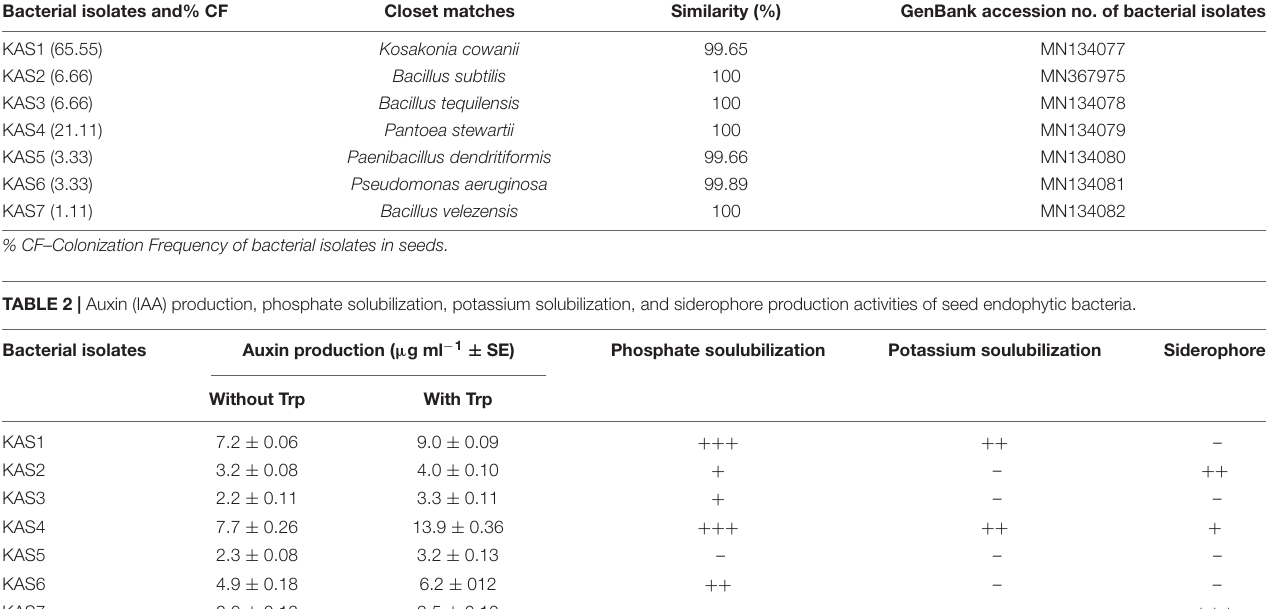
TABLE 1 | List of molecularly identified endophytic bacteria using 16S rDNA sequencing with their closet matches, percentage similarity and accession no. of isolates. Bacterial isolates and% CF